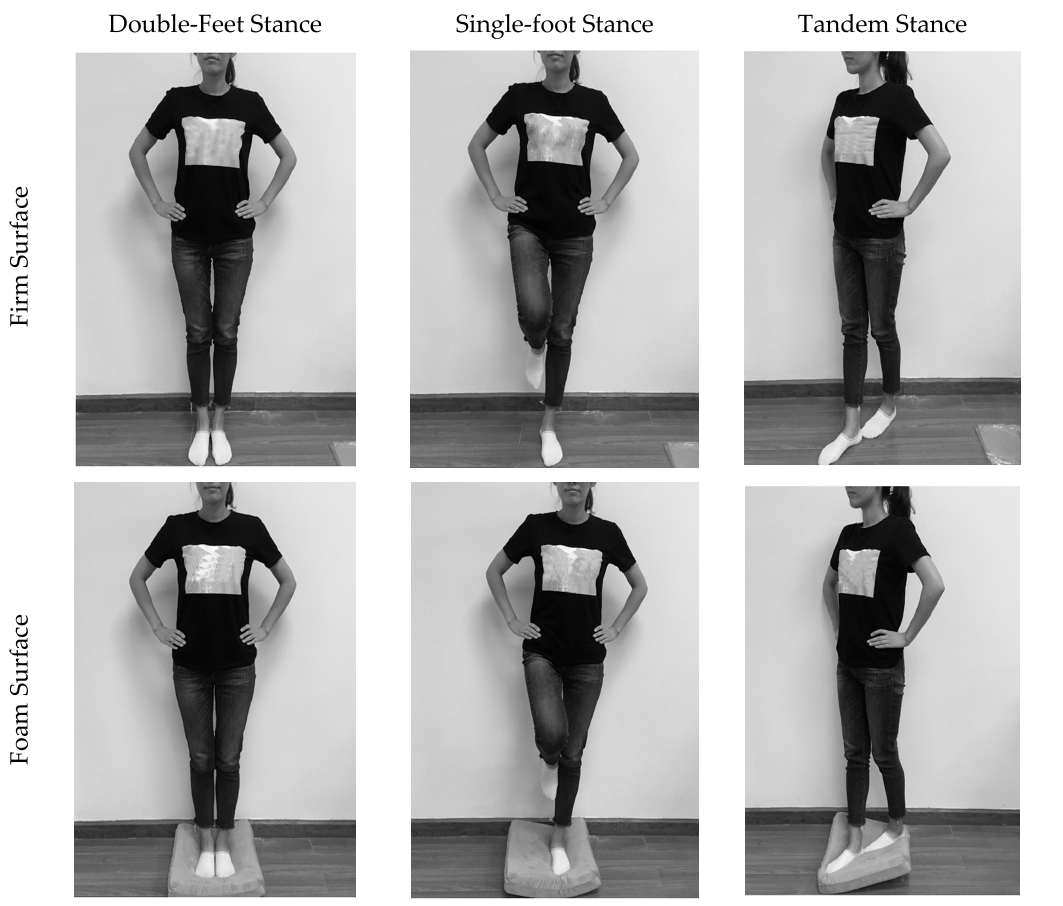
Figure 1. Trials of BESS test in three different stances (double feet, single foot and tandem) on two different surfaces (firm and foam).